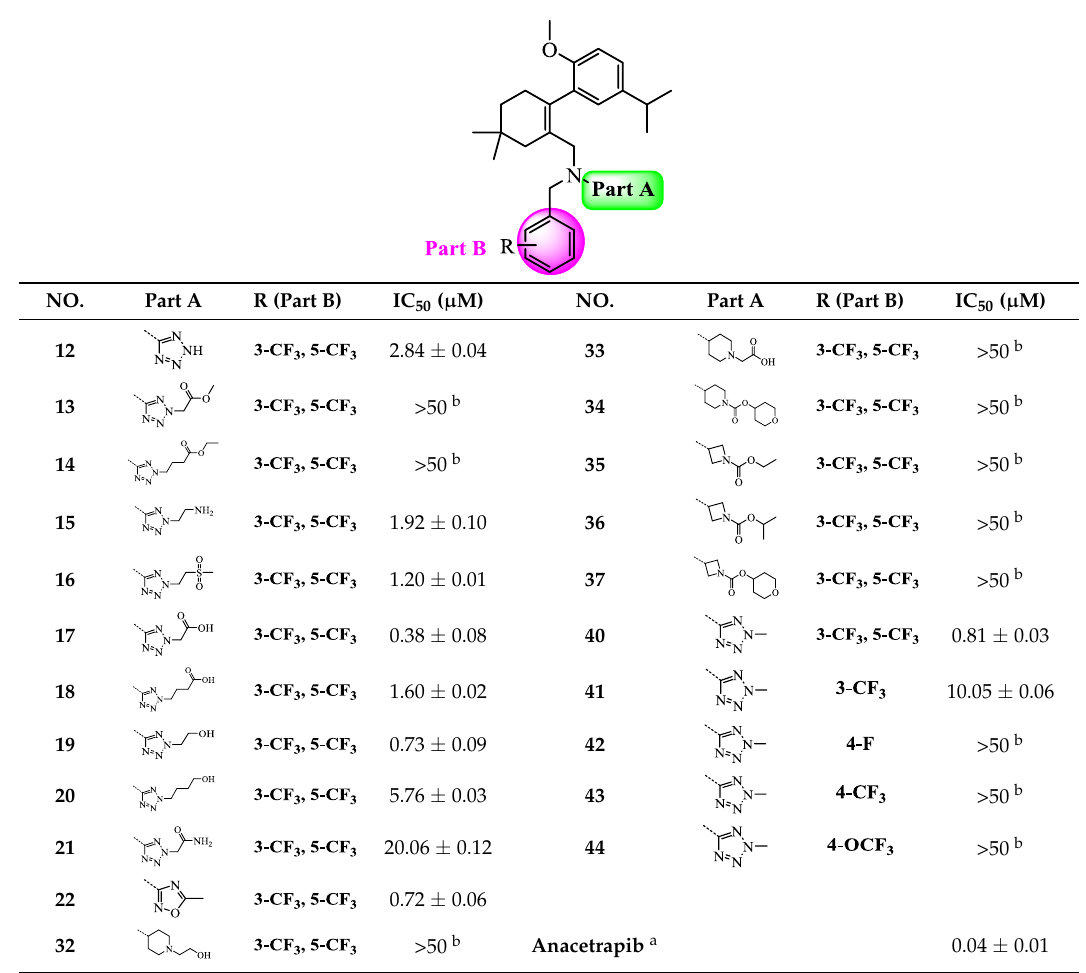
Table 2. In vitro DMPK profile.